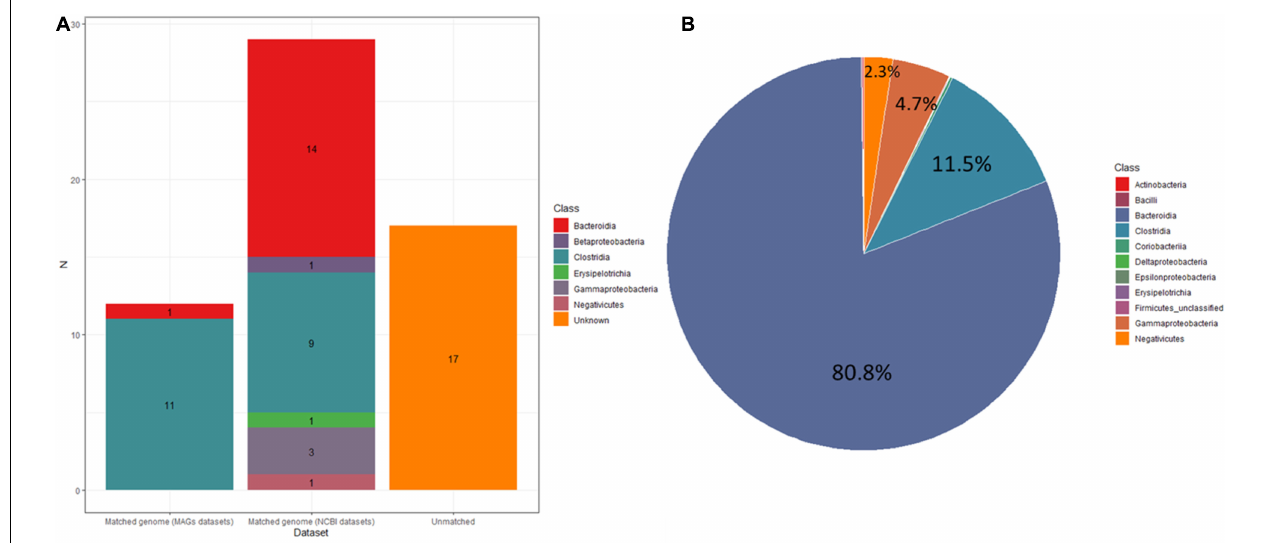
FIGURE 7 | (A) Stacked bar plots showing the number of MAGs matched in UMGS and HR datasets or unknown. (B) Pie figure showing relative abundance of the gut microbiota. The different colors represent different bacteria at class level.